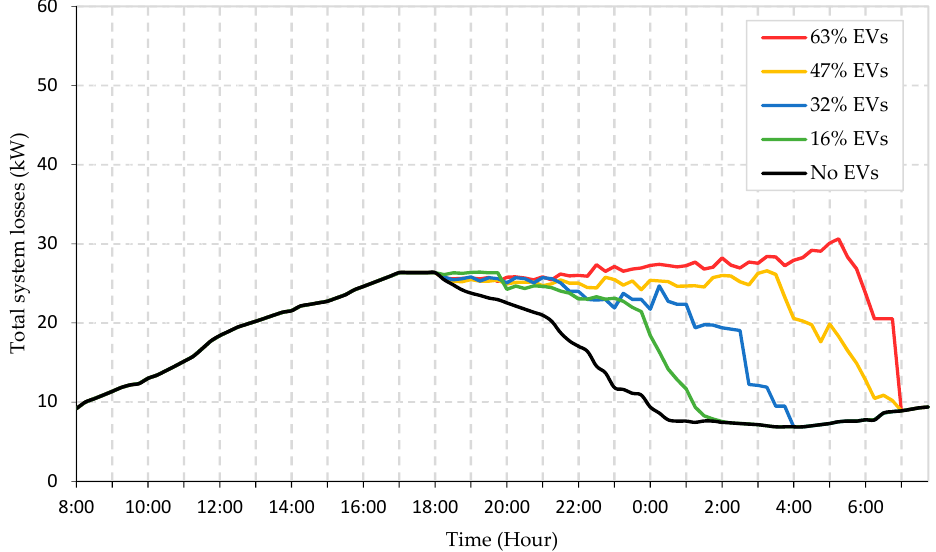
Figure 10. Impact of coordinated EVs’ charging on voltage at worst nodes.